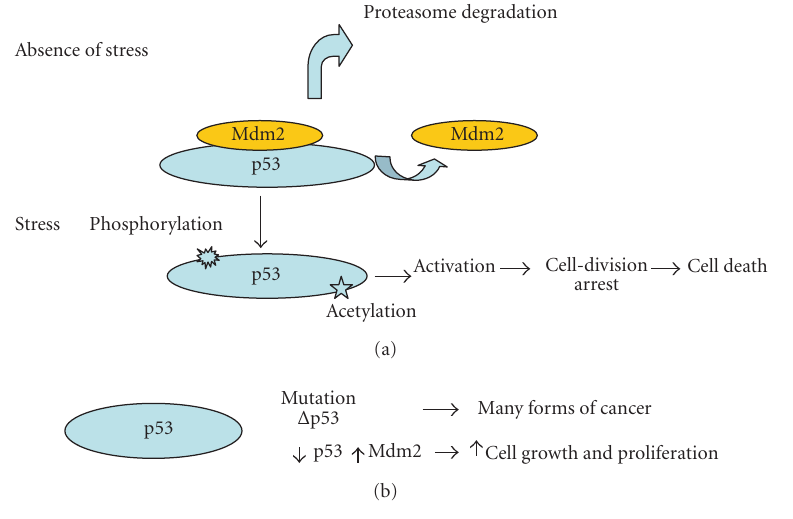
Figure 1: Schematic representation of some modifications a ff ecting p53 leading to cell growth and proliferation or death. (a) Under stress conditions, phosphorylation of p53 and release from Mdm2 and further acetylation led to p53 activation; (b) mutations of p53 and the modifications in the levels of p53/Mdm2 might a ff ect cell growth and